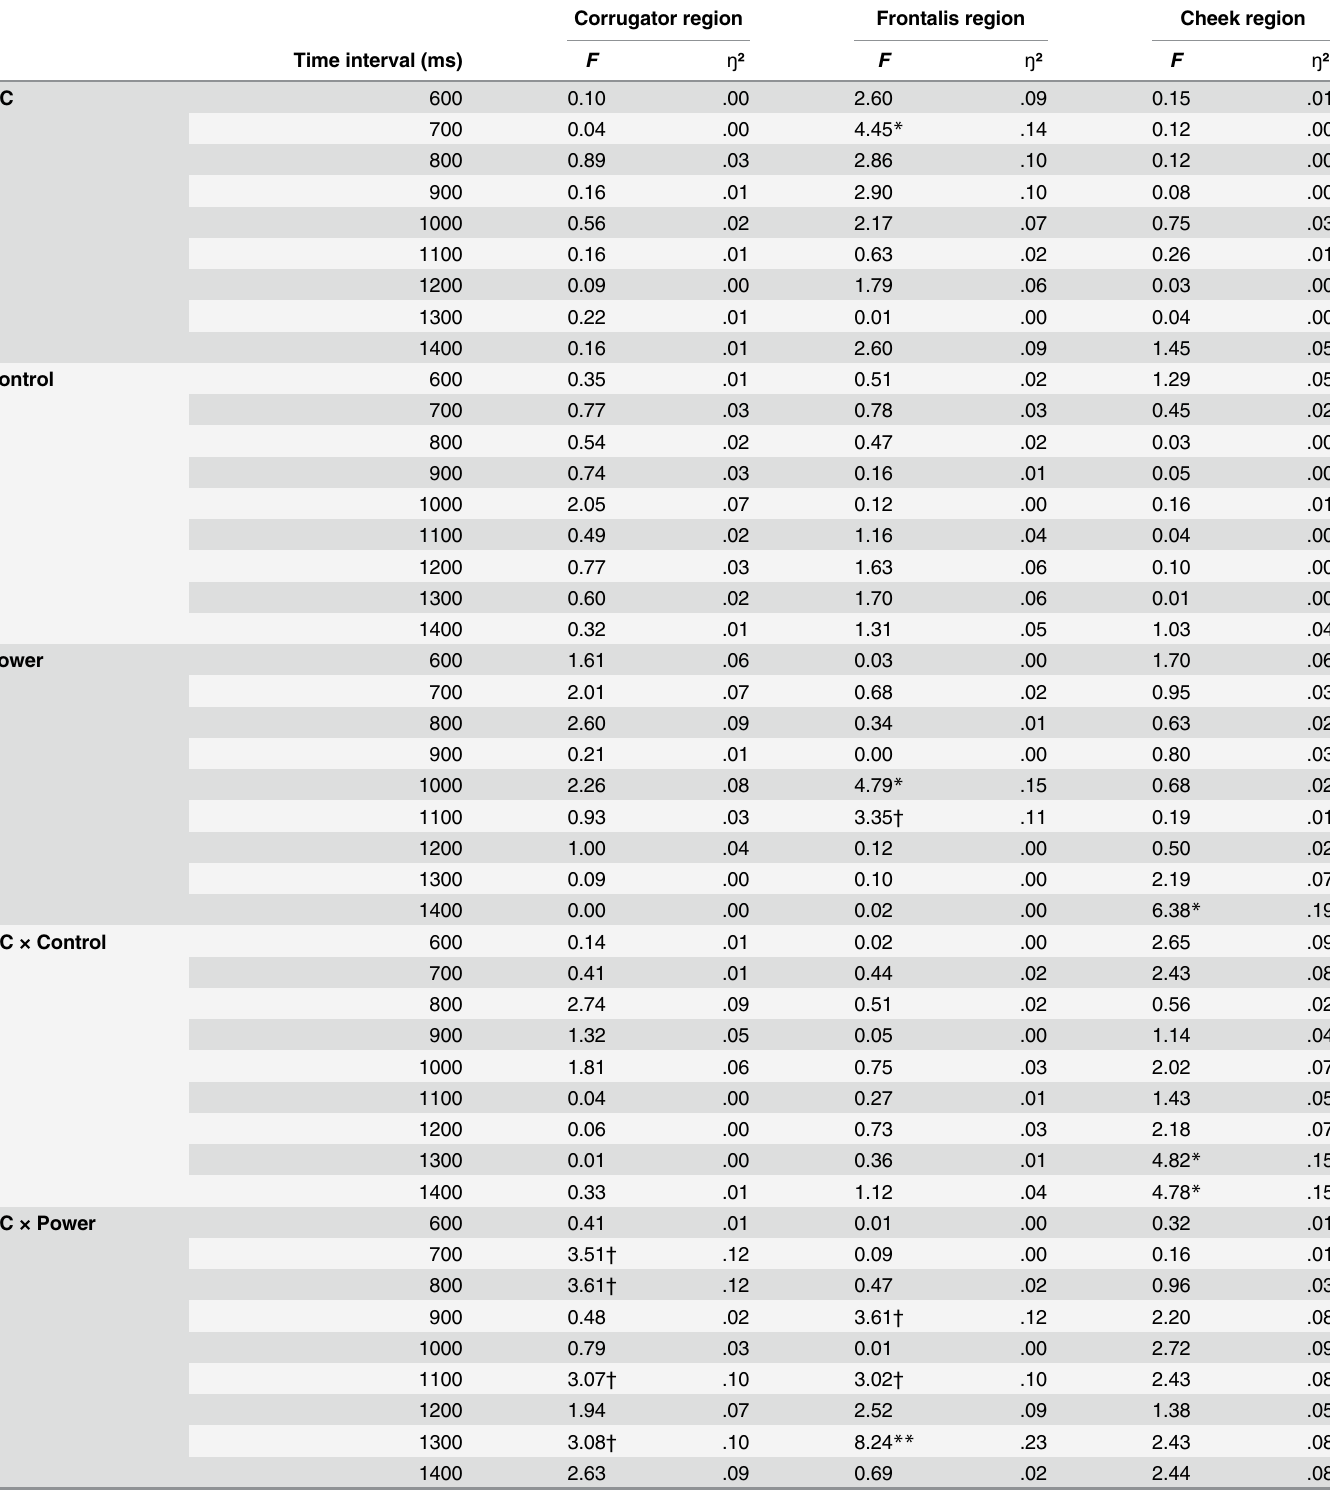
Table 3. Results of the Planned Comparisons for Each Facial